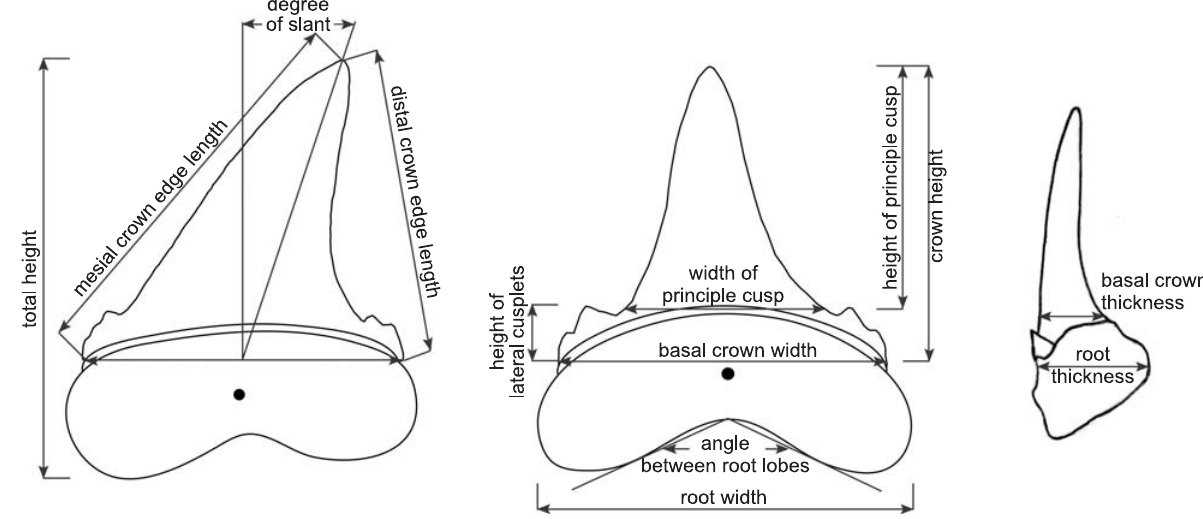
Fig. 3. Tooth measurements used in this